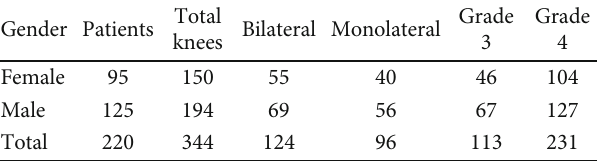
Table 1: Patients with KOA receiving